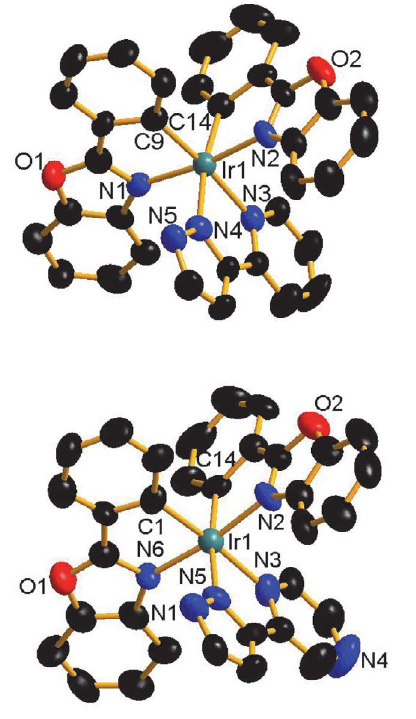
Fig. 1. ORTEP view of 2a (up) and 2b (down) with the thermal el- lipsoids drawn at the 50% probability level. Hydrogen atoms and solvent molecules are omitted for clarity.